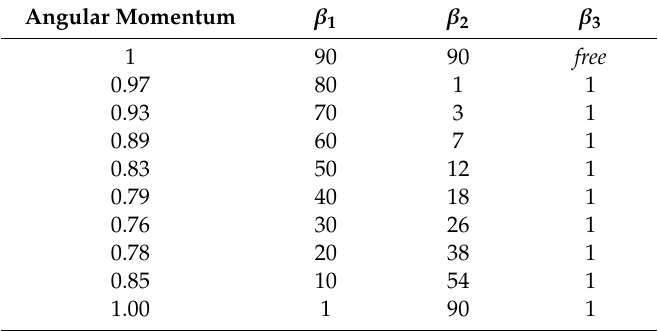
Table 5. Singularity-Free Maximum Angular Momentum Values for Mixed Skew Angles.